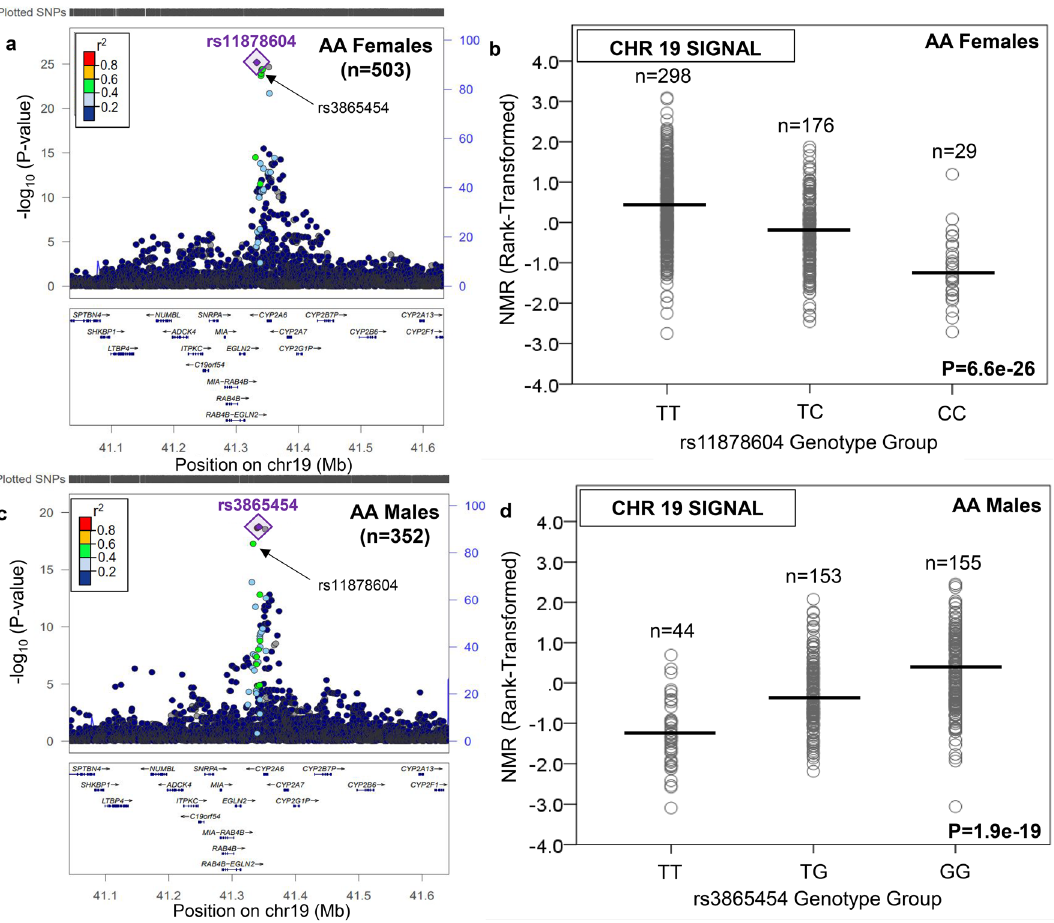
Figure 2. The top signal associated with the Nicotine Metabolite Ratio in African ancestry females and males was found on chromosome 19 in the region containing CYP2A6 . The nicotine metabolite ratio was rank- transformed for analysis. Regional plots were generated using LocusZoom 44 (freely available at locuszoom. org). In African American (AA) females, the top variant was rs11878604 ( a ), which was also significant in AA males. The influence of rs11878604 on the Nicotine Metabolite Ratio (NMR) in AA females is shown in ( b ). In AA males, the top variant was rs3865454 ( c ), which was also significant in AA females. The influence of rs3865454 on the NMR in AA males is shown in ( d ). Note: in AA females, there was a second independent signal on chromosome 19: the top variant was an indel at position 41352257 (P = 8.3e−9, after conditioning on rs11878604); this variant was also GWS in AA males. Linkage disequilibrium patterns in ( a ) and ( c ) are based upon the hg19/1000 Genomes November 2014 release African reference population. The plots in ( b ) and ( d ) were created using SPSS version 23 (can be purchased from IBM, Armonk, New York, USA). The black horizontal line represents the mean rank-transformed NMR in each group, and the P-value is from the GWAS after adjusting for population substructure and NMR